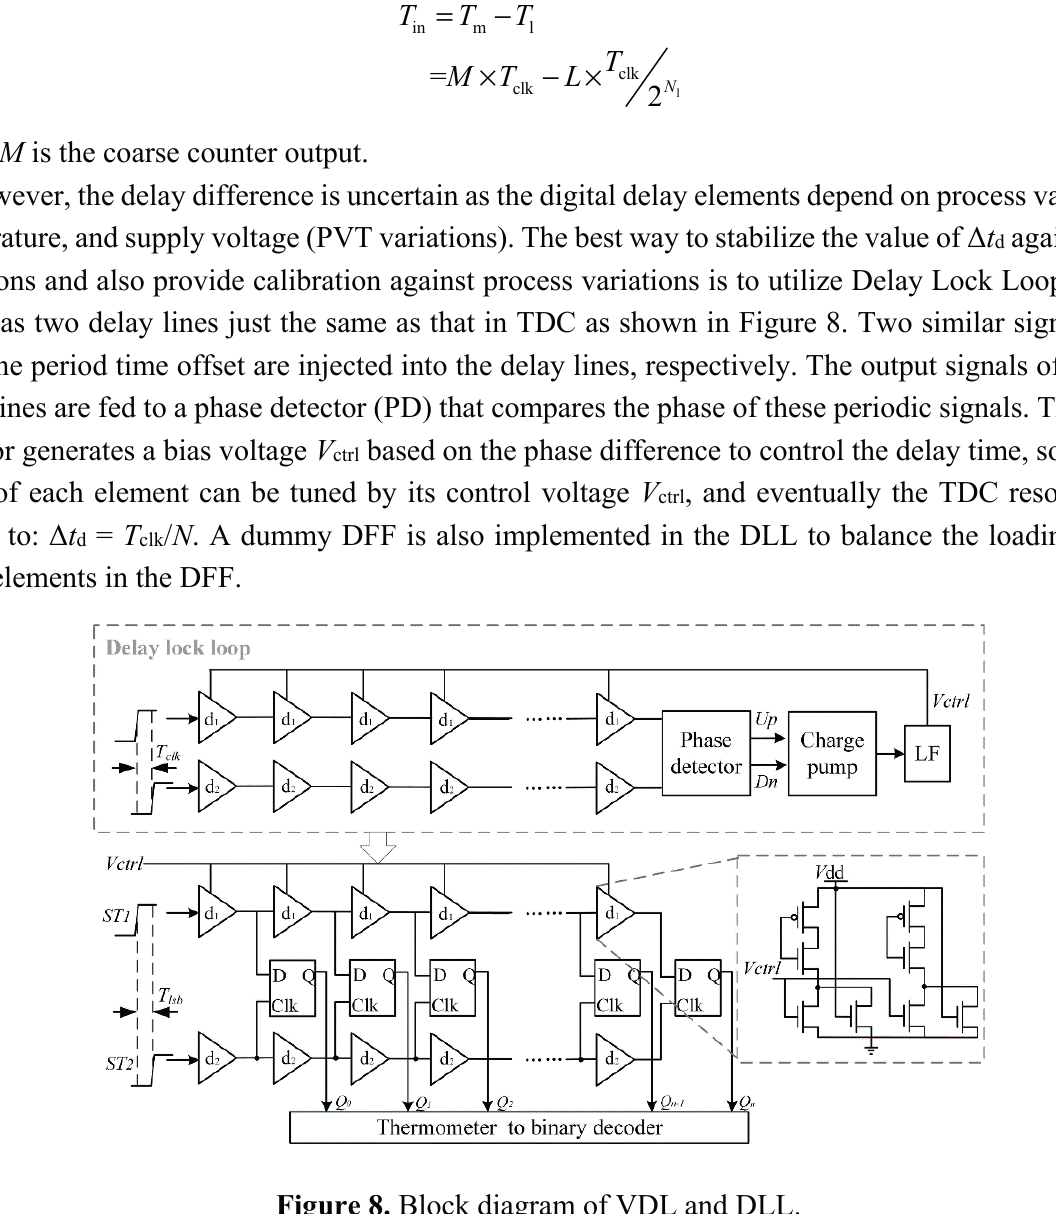
Figure 8. Block diagram of VDL and